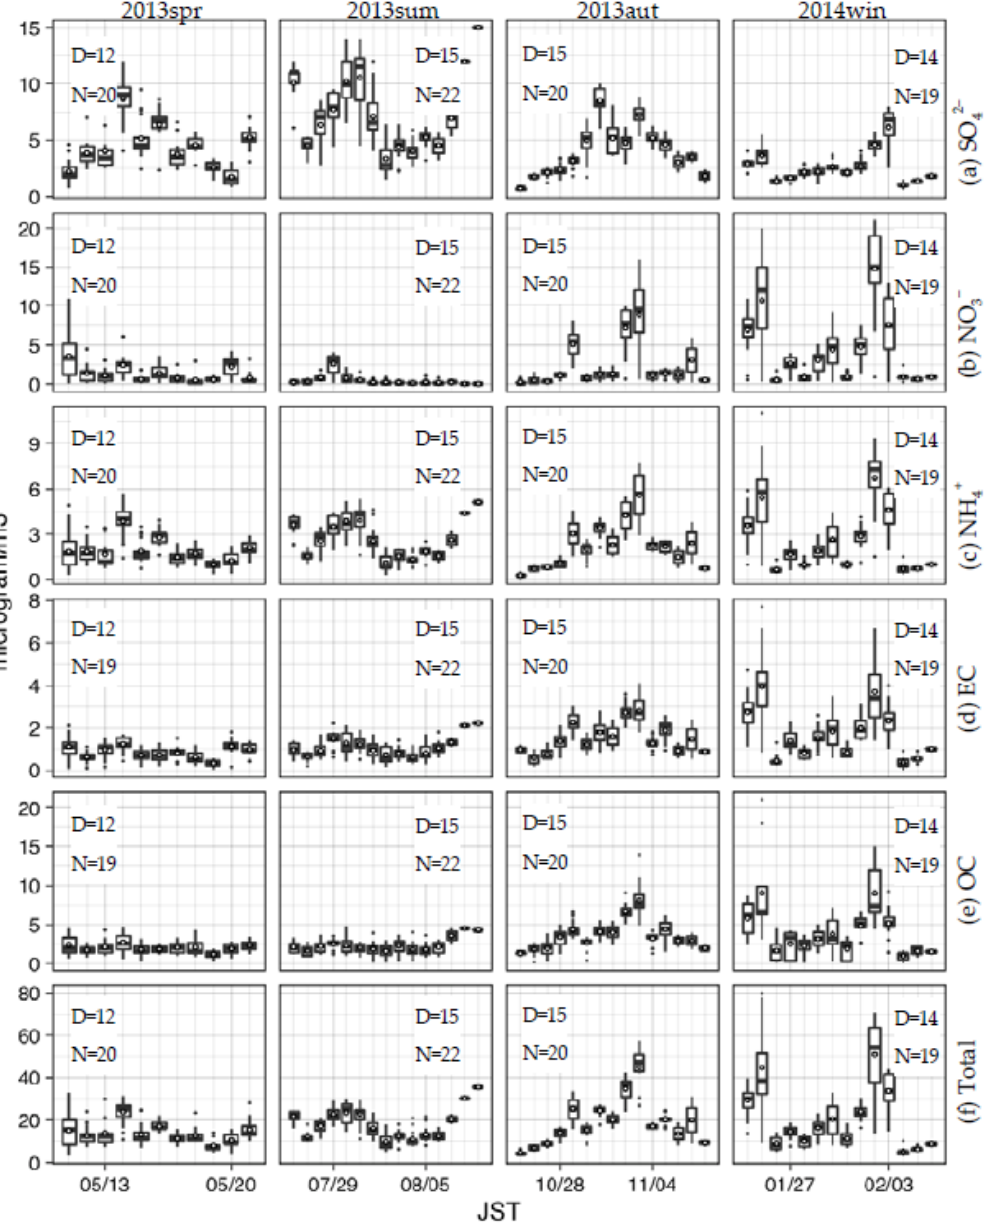
Figure 5. Box-plots of observed daily concentrations of total PM 2.5 and its components: ( a ) SO 42– , ( b ) NO 3 − , ( c ) NH 4 + , ( d ) EC, ( e ) OC, and ( f ) total PM 2.5 mass, at AAPMSs within d04 for the four seasons. The open circles indicate spatially averages obtained from daily concentrations observed at AAPMSs within d04. The black dots indicate the outliers. The box-and-whisker and outliers represent the frequency distributions of daily concentrations observed at AAPMSs in d04. D presents the numbers of days with available observations, and N presents the number of AAPMSs.